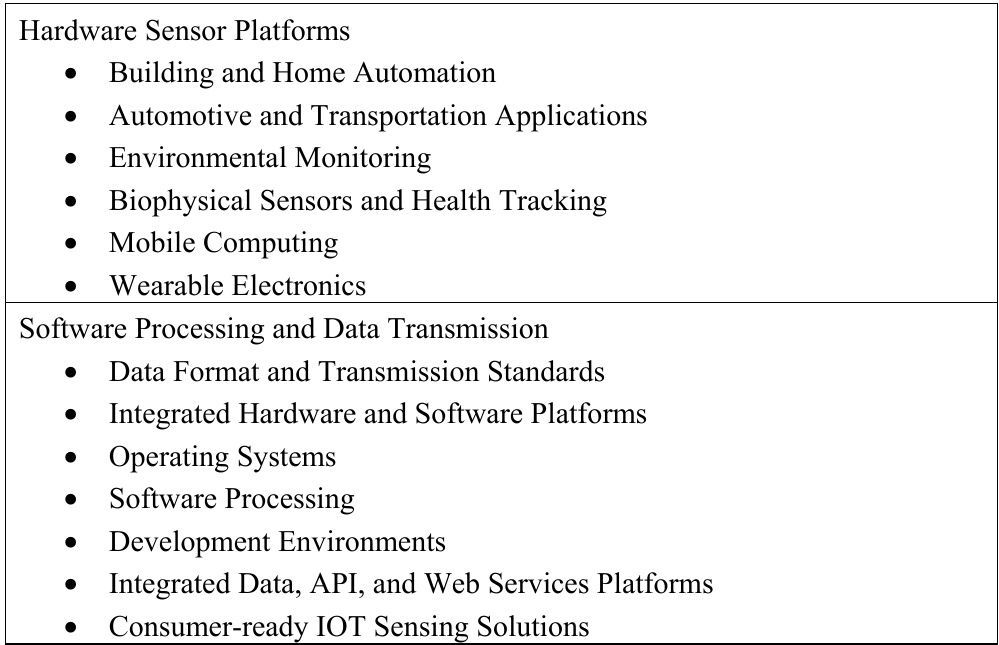
Figure 17. Internet of Things Research